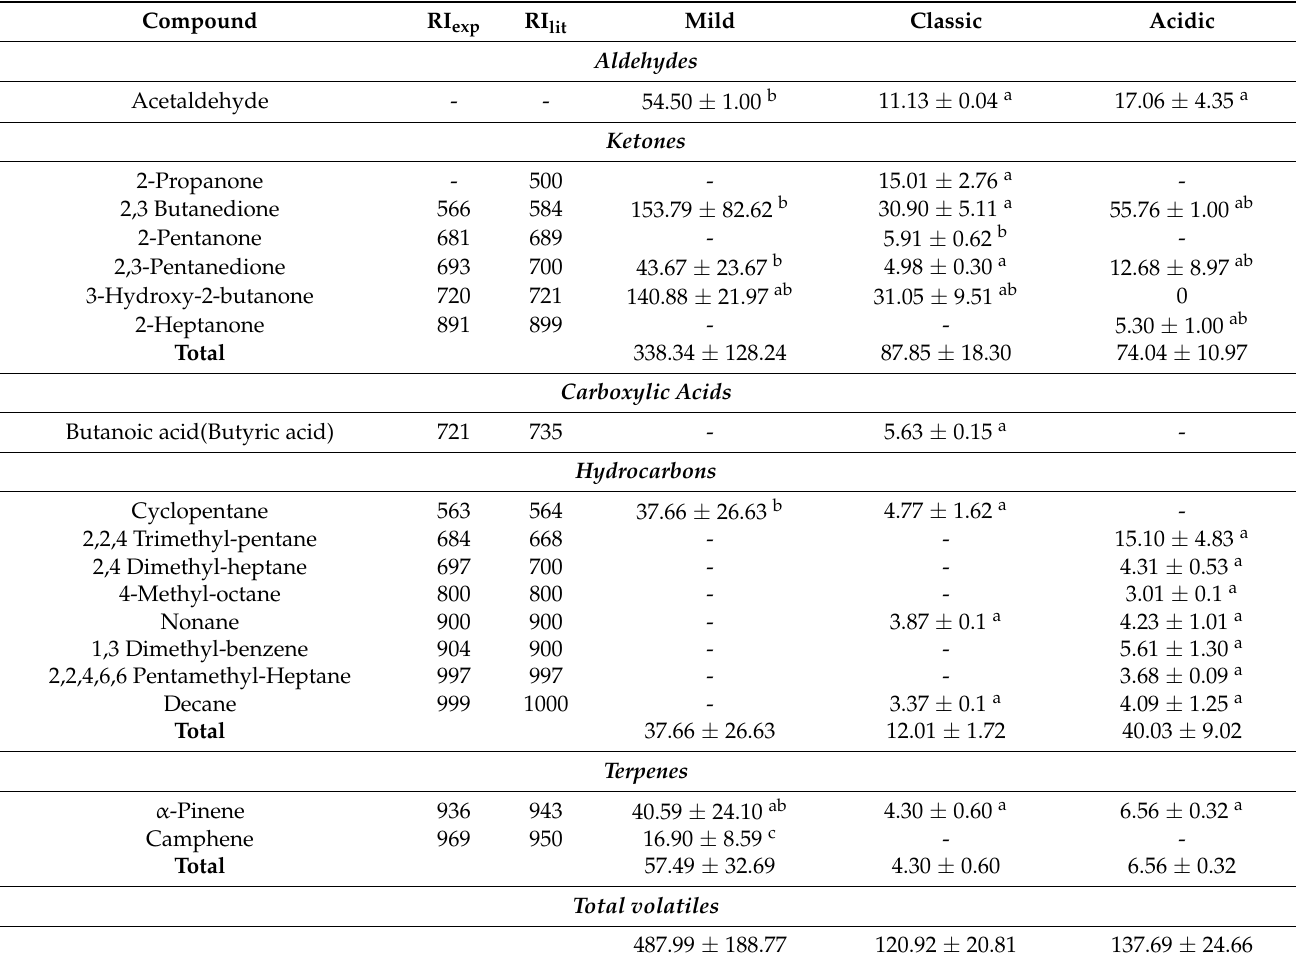
Table 4. Volatile compounds of goat dessert yogurts (mg kg − 1 ), prepared with different cultures with the addition of Lactobacillus acidophilus